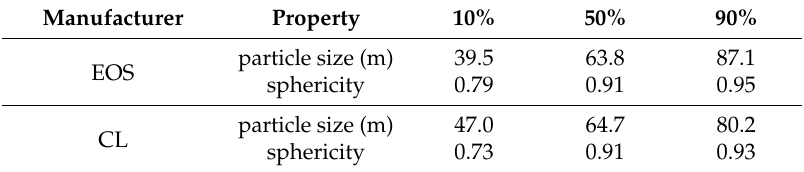
Table 2. Cumulative distribution of the AlSi10Mg alloy powder particle size and sphericity.